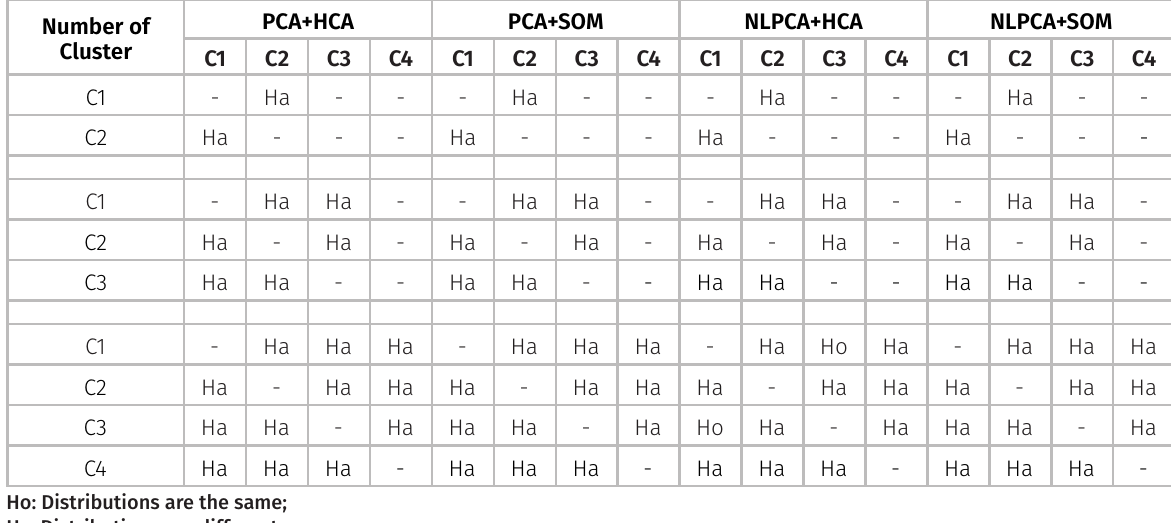
Table IV. Results of Kolmogorov-Smirnov